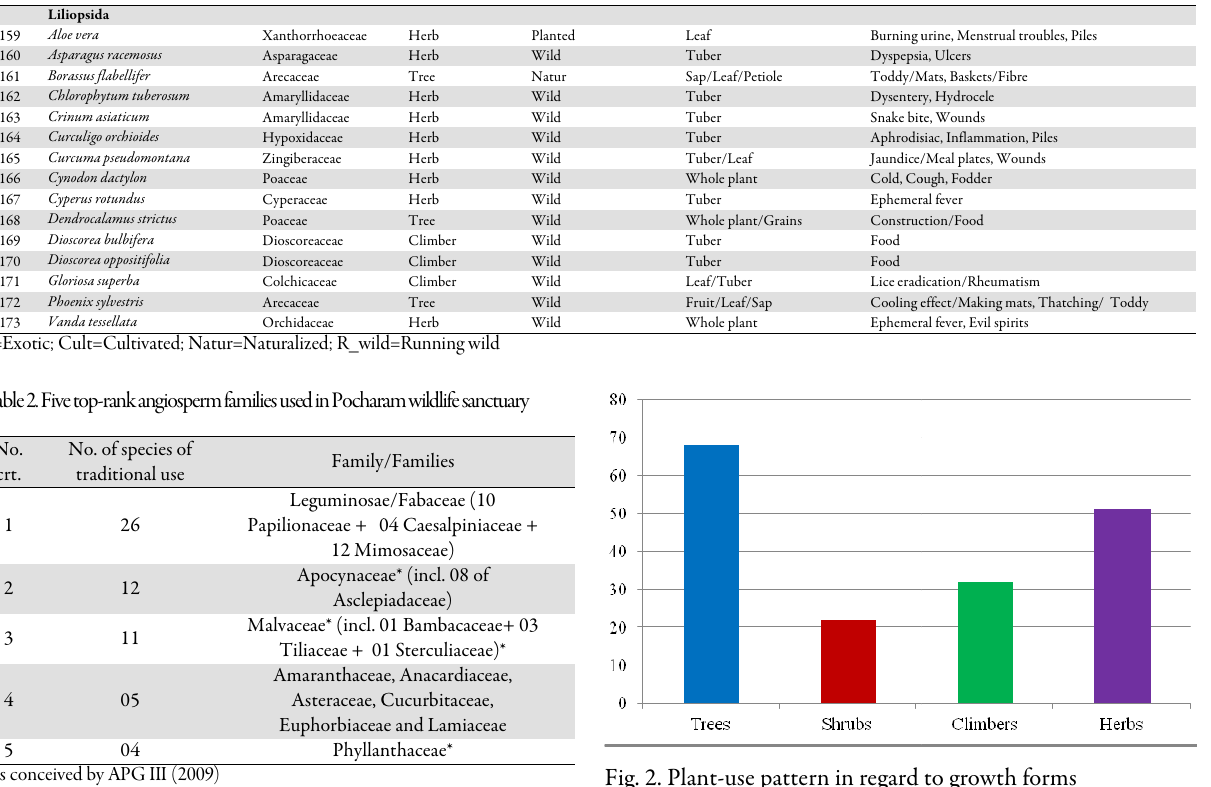
Plants are usually classified as trees, shrubs, climbers